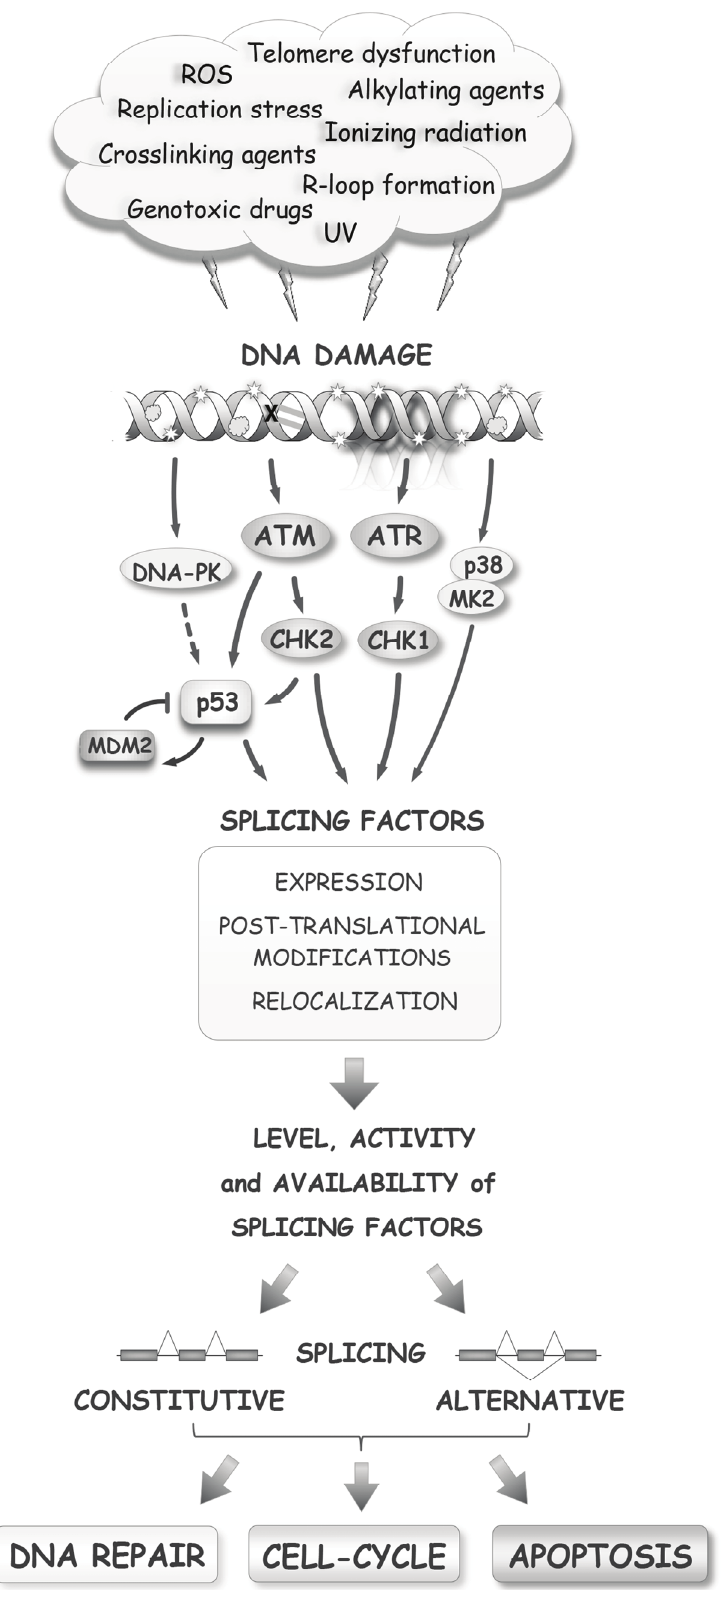
Figure 1. The RNA splicing response to DNA damage. Several early and late steps of the DNA damage response alter processes that impact the activity of splicing factors, ultimately affecting the production, through splicing, of components that maintain genome integrity and control cell